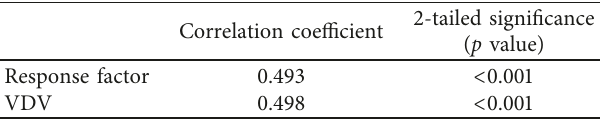
Figure 7: The relationship between the annoyance rating and VDV of (a) the bedroom and (b) the rest area in a gym. Table 4: Result of partial correlation analysis between the an- noyance rating and acceleration (in terms of response factor and